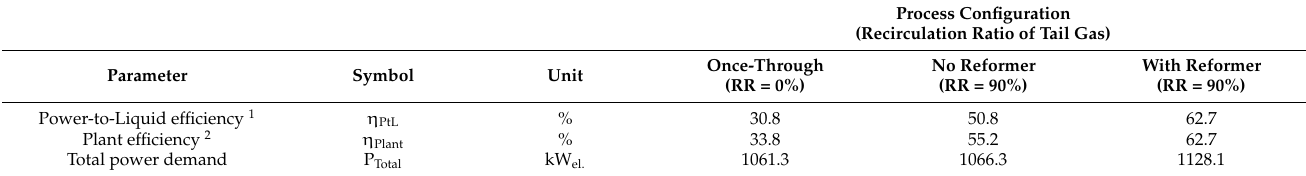
Table 6. Power-to-Liquid efficiency and plant efficiency for the chosen process configurations.